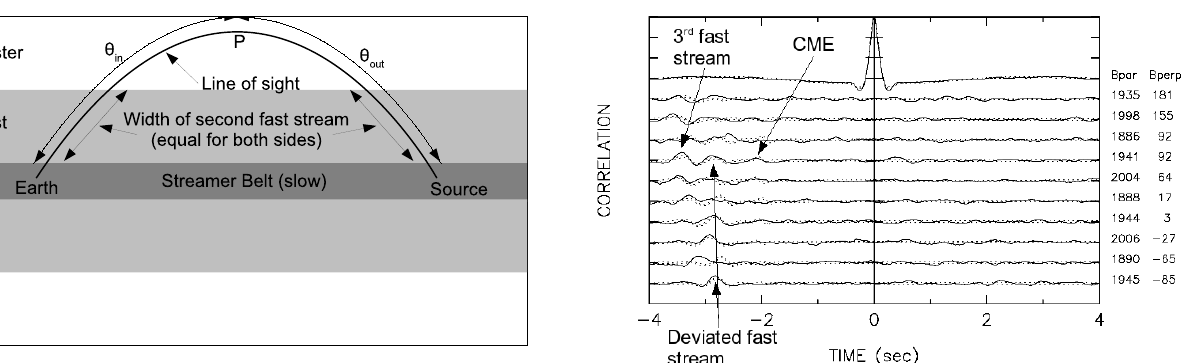
Fig. 5. Auto- (top line) and cross-correlation functions for the EISCAT-MERLIN observation of J0319+415 (3C84) after 14:10UT on 14 May 2005. The peaks associated with the perturbed back- ground solar wind flow and with the CME are marked “Deflected fast wind” and “CME”, respectively. The solid lines are the ob- served functions and the broken lines the weak-scattering model fit. The parallel and perpendicular baselines (Bpar and Bperp) are given in km. After Breen et al.